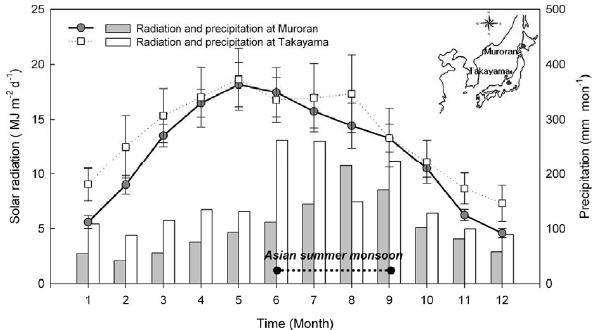
1 Fig. 7. 2 Fig. 7. Variations of averaged daily solar radiation per 3 month at Muroran (42 ◦ 32 0 N: 140 ◦ 97 0 E) and Takayama (36 ◦ 9 0 N: 137 ◦ 15 0 E) in Japan. The period of solar radiation data used was 1973-2003 for Muroran and 1961-1973 for Takayama (http://www.